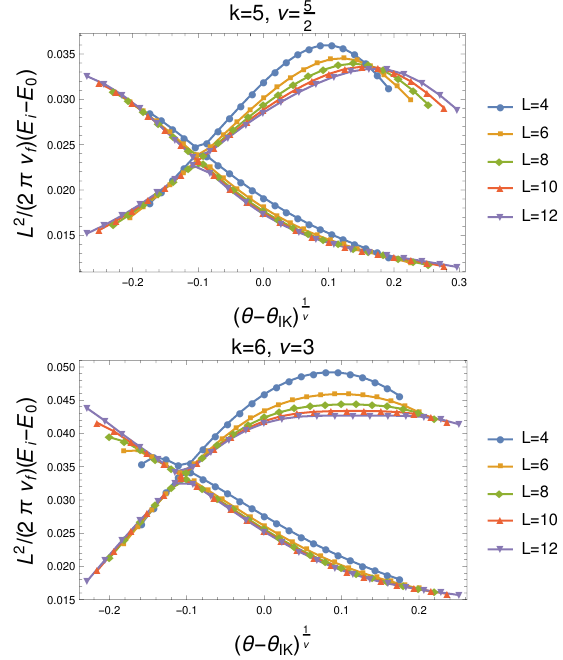
2 ( E − E ) associated with the two first excited levels, E i 0 2 π v f